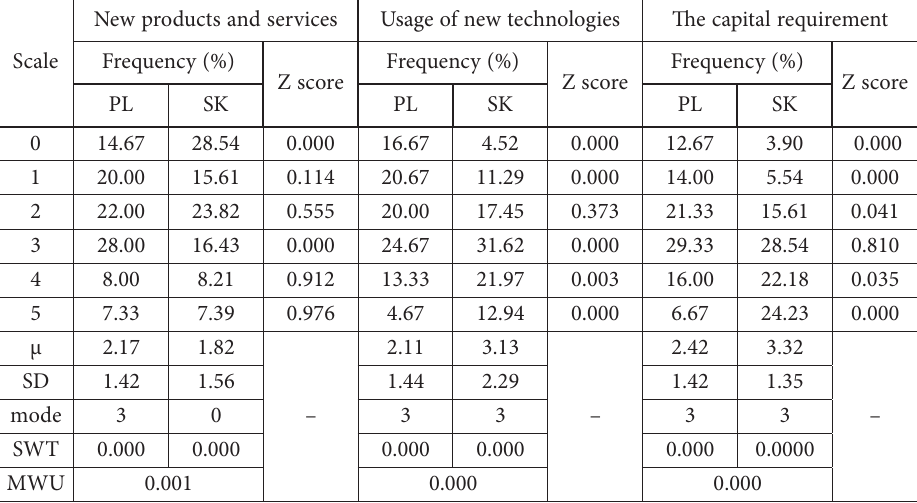
Table 5. New products and services, usage of new technologies and the capital requirement of SMEs